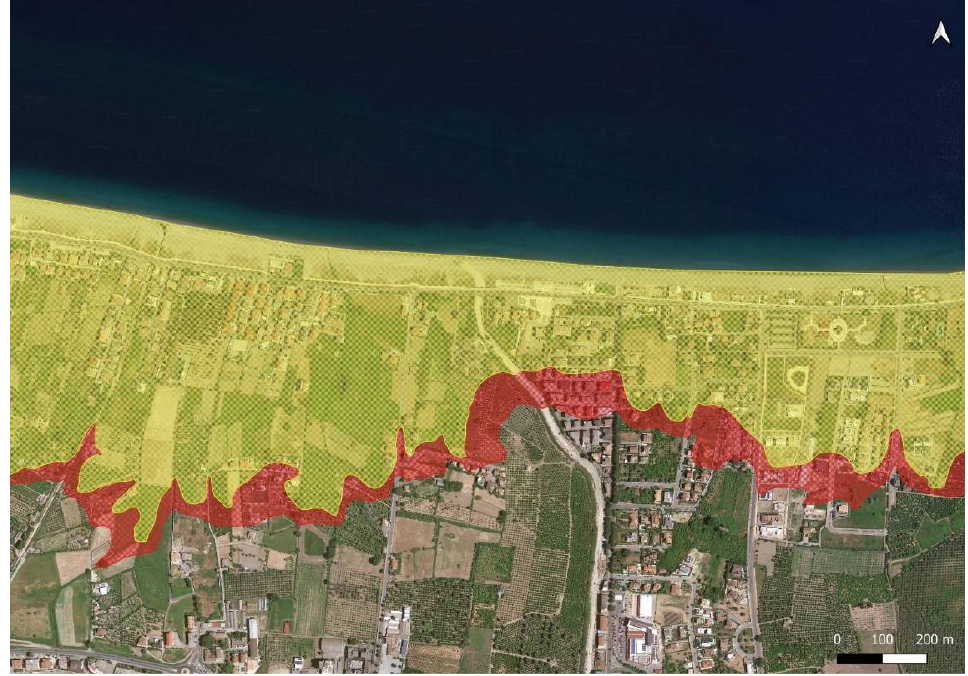
Figure 3. Rossano. Legend: Yellow, the floodable area in the current scenario; red, the floodable area in the future scenario.